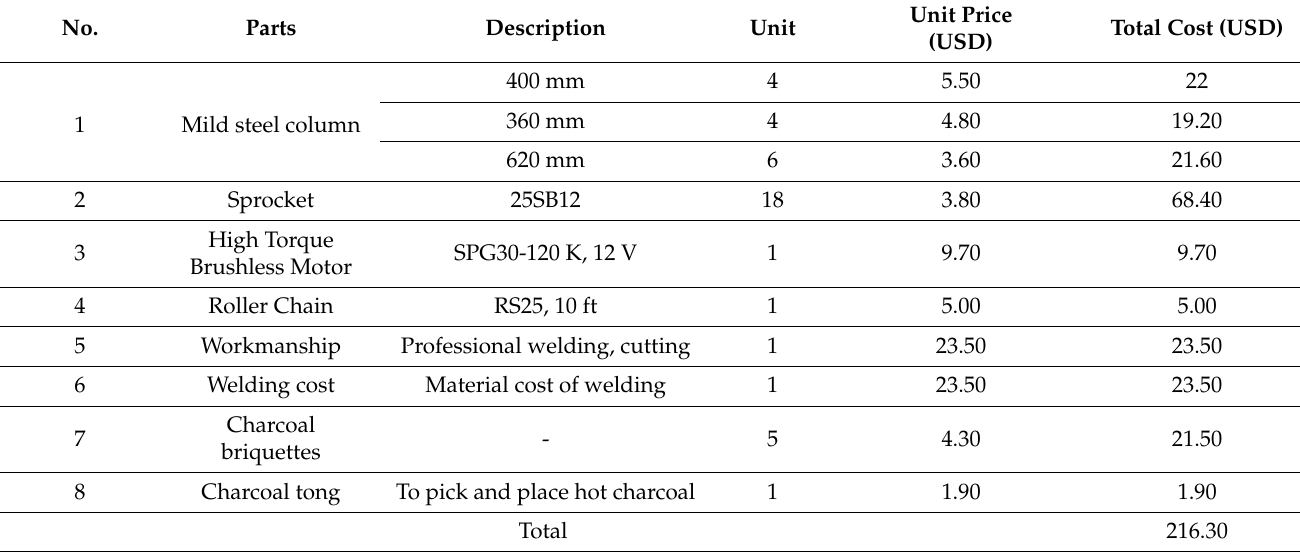
Table 18. Price list for the product